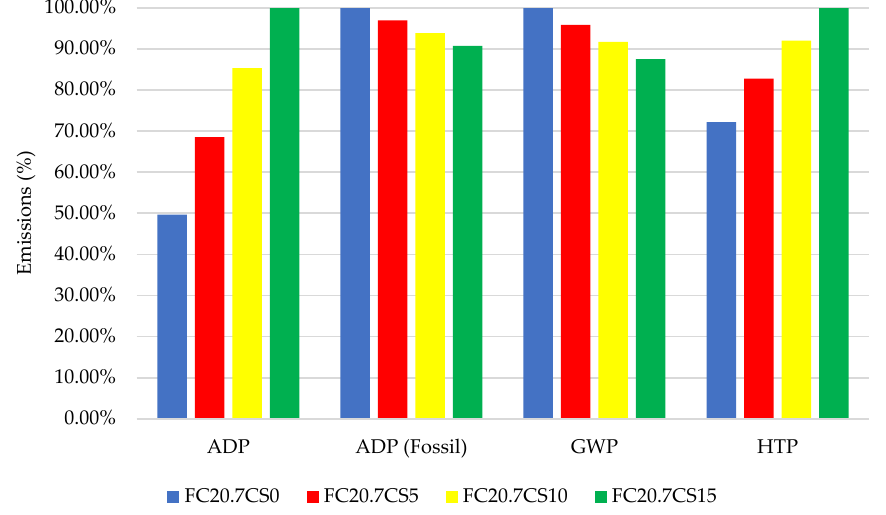
Figure 3. Impact assessment of 20.7 MPa concrete systems.